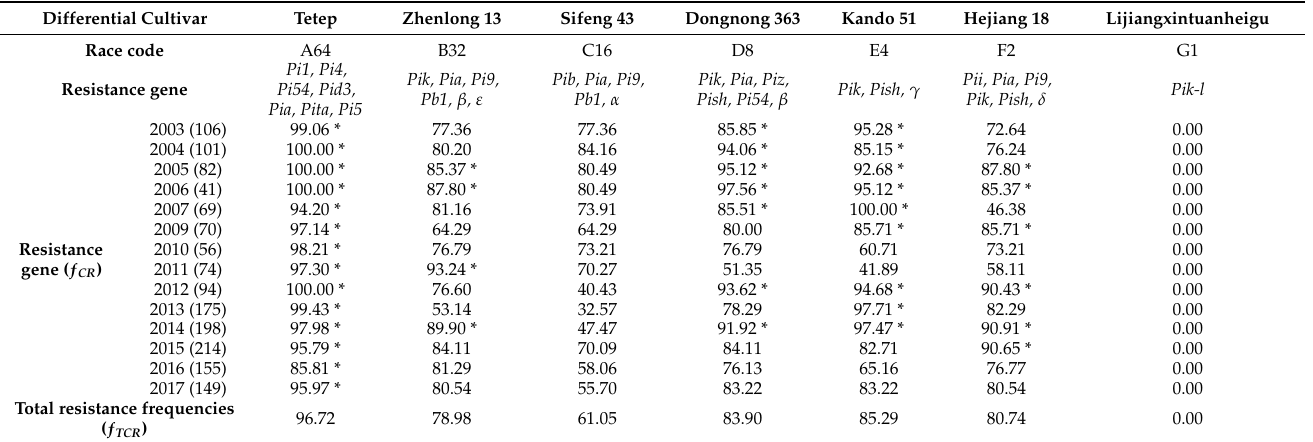
Table 4. Resistance genes and resistance frequency of a set of CDC entries that were challenged with isolates collected in Jiangsu province from 2003 to